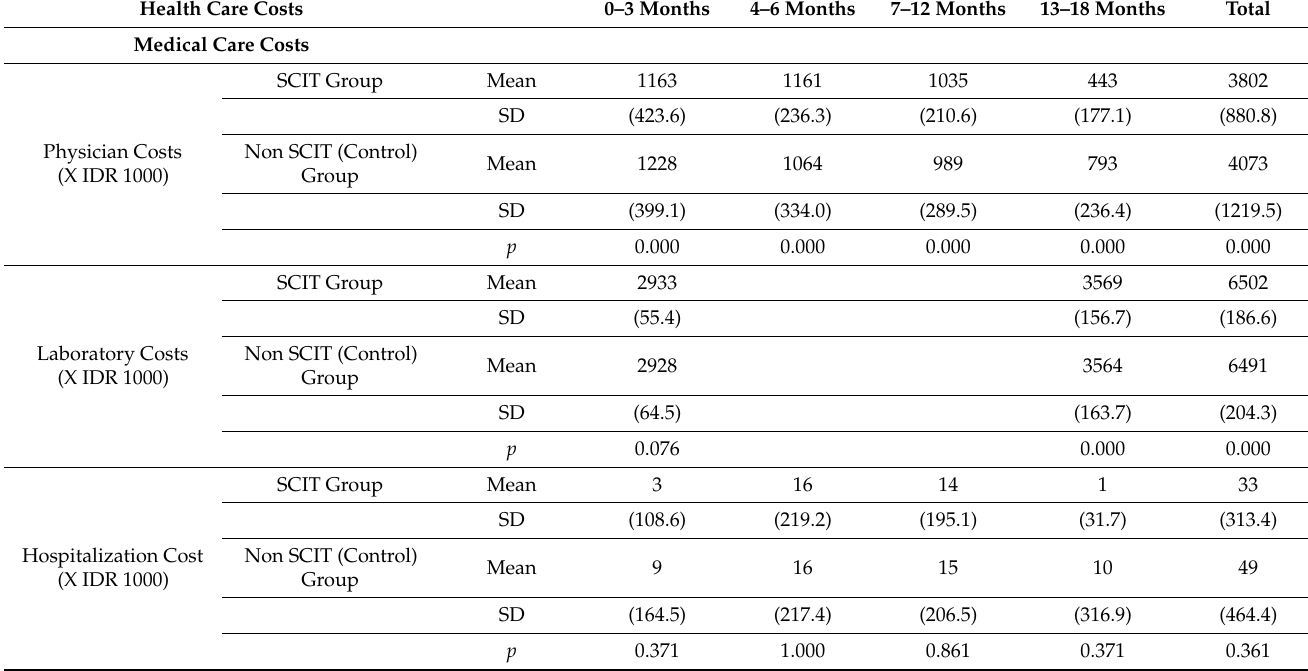
Table 6. Health care